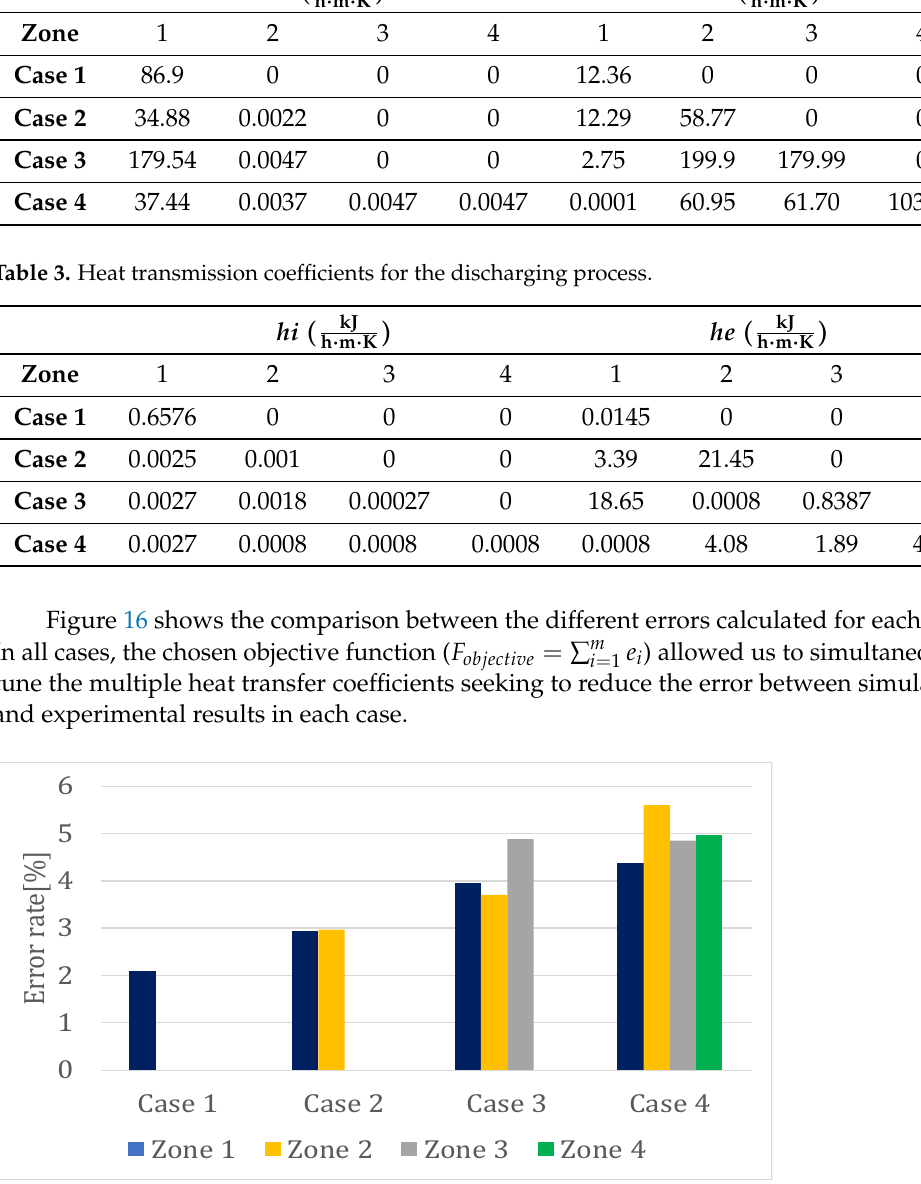
Figure 16. Error rate for each zone and case